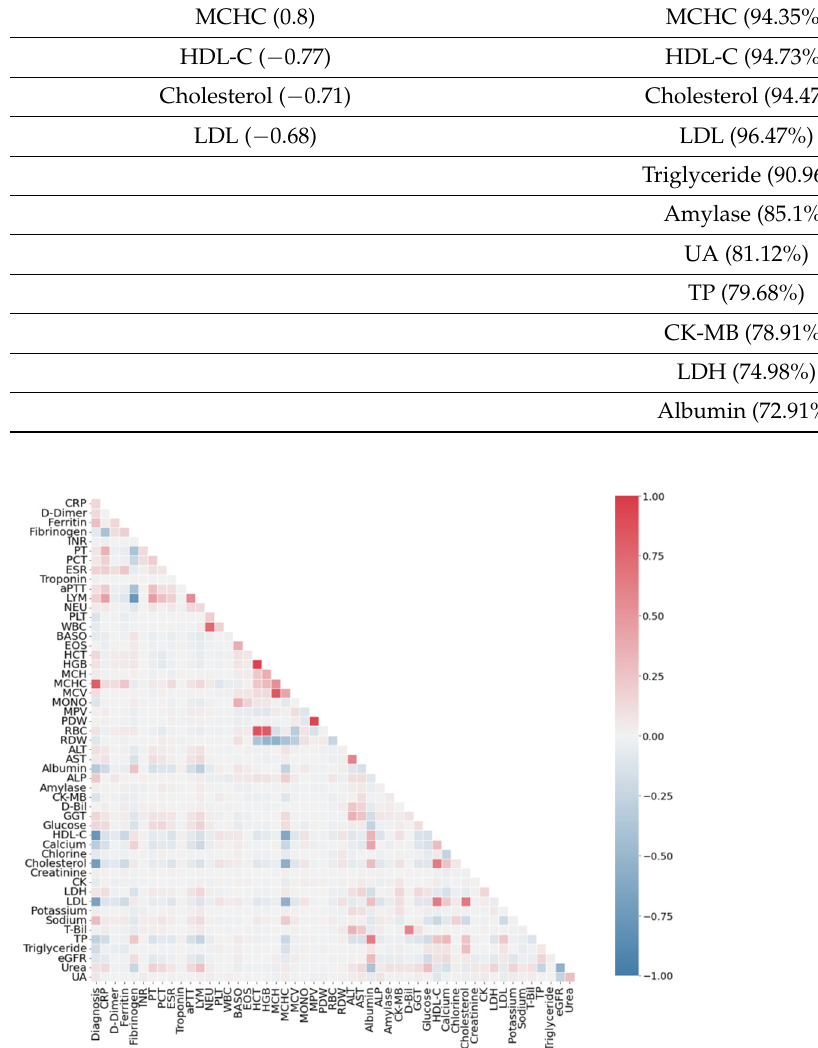
Table 3. Features most strongly correlated with the diagnosis according to the point-biserial correla- tion coefficient and the threshold correlation method.